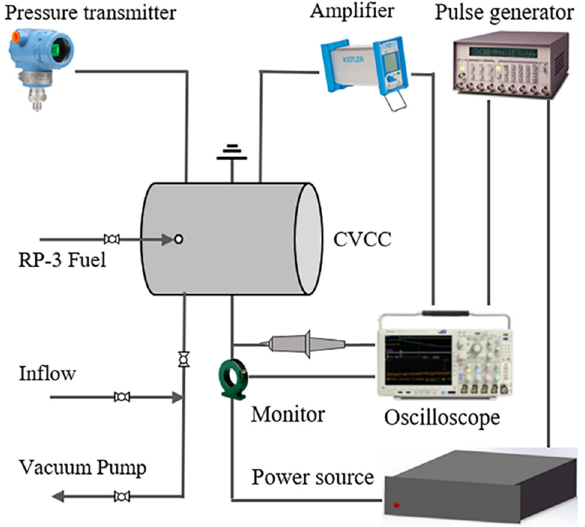
Figure 1. Schematic diagram of the experimental apparatus. The combustion vessel is cylindrical with inner diameter of 180 mm, and volume of 5.58 L. Two tungsten electrodes with a diameter of 0.5 mm are located in the center of the vessel and the electrode gap is fixed at 3 mm. Both electrodes are isolated from the stainless-steel combustor with customized inserts made of Teflon insulating